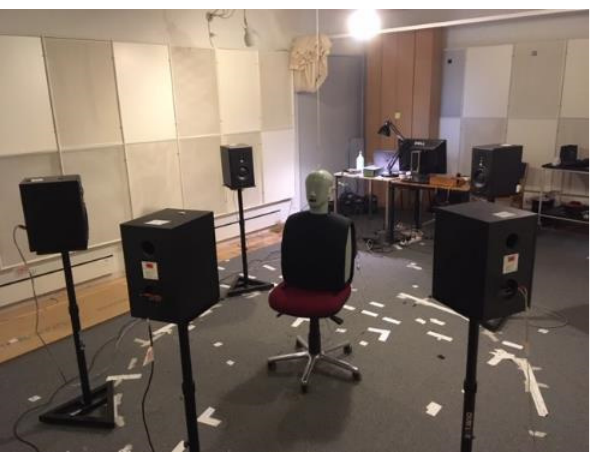
Figure 3. Picture of the test setup used for performing the SNR improvement measurements.